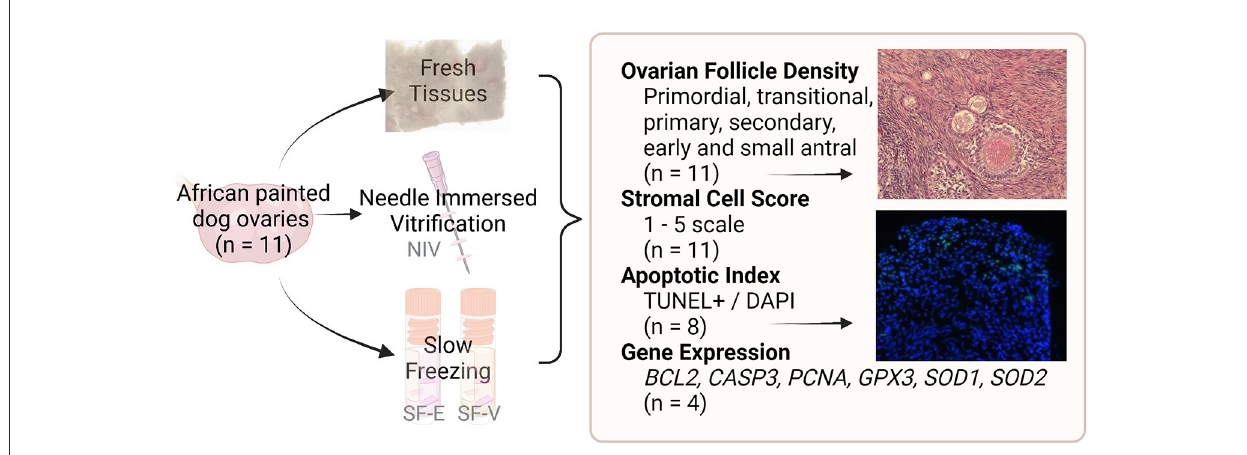
FIGURE1 Study design flowchart. African painted dog ovaries ( n = 11 individuals) were processed for either needle immersed vitrification (NIV) or slow freezing with either 7.5% DMSO and EG (SF-E), or 15% DMSO and EG with 0.5M sucrose (SF-V). Fresh tissues, as well as post-warming cryopreserved tissues were fixed or flash-frozen for evaluation of ovarian follicle density ( n = 11), stromal cell architecture ( n = 11), apoptosis ( n = 8), or gene expression ( n =